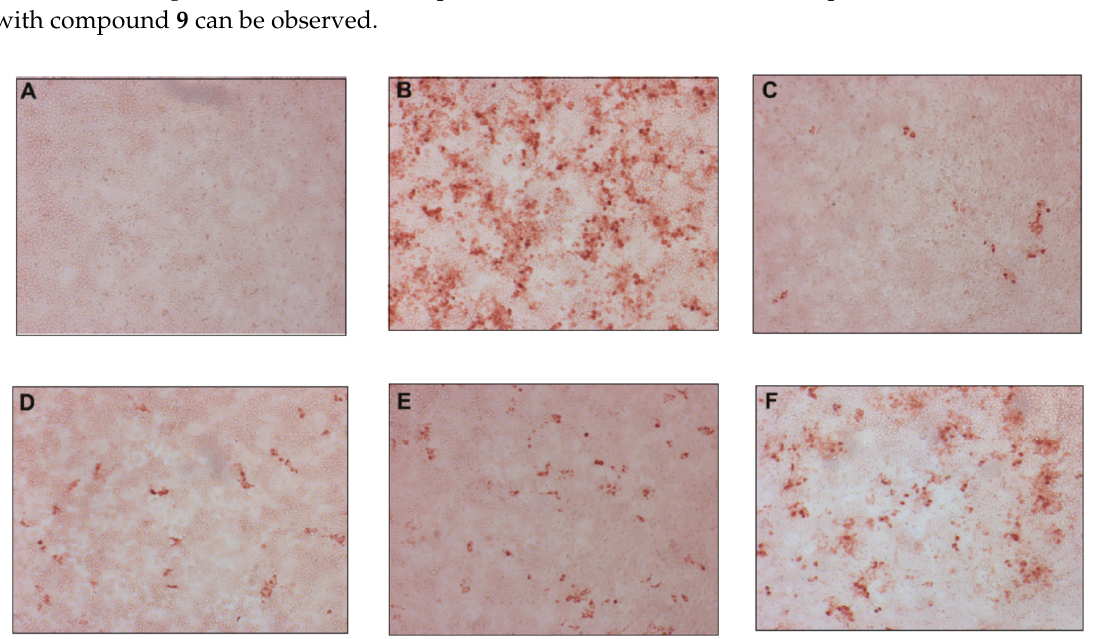
are shown in Figure 2, where a dose-dependent inhibition of viral HCV replication after treatment with compound 9 can be observed.